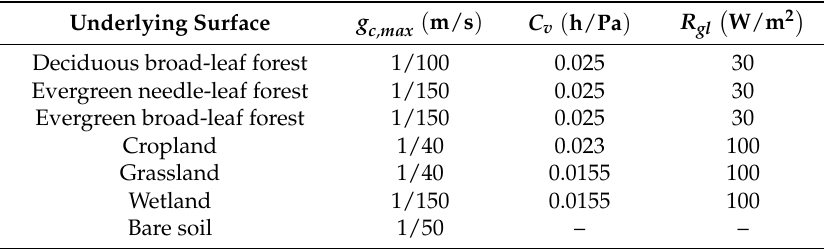
Table 2. Surface-dependent parameters